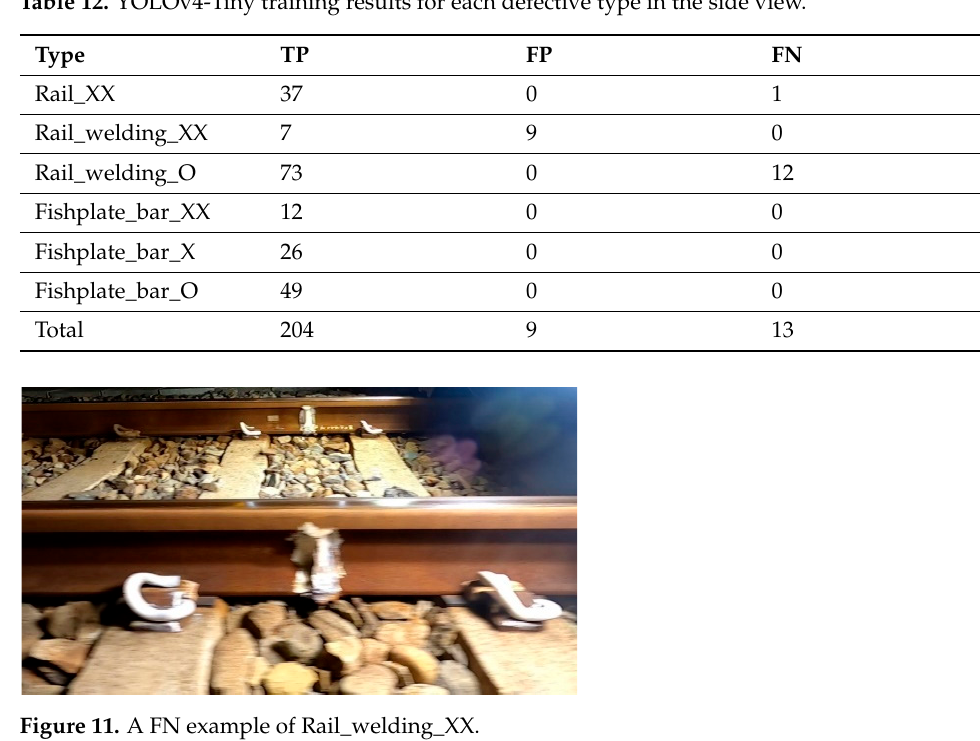
Table 11. YOLOv4 training results for each defective type in the side view.